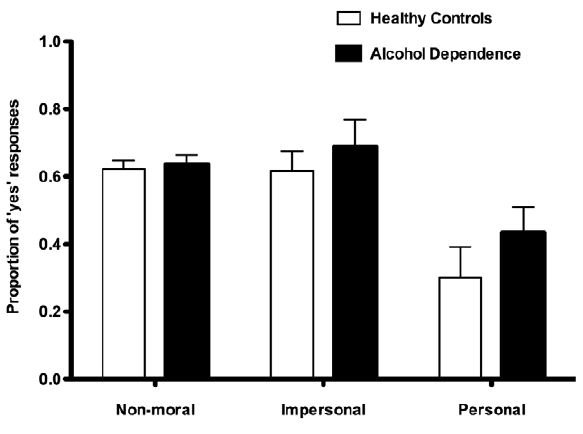
Figure 1. Moral judgments of three classes of dilemmas: non- moral, impersonal moral and personal moral dilemmas. The proportion of ‘yes’ responses are shown for the two groups. Alcohol dependent patients were more likely than healthy controls to respond ‘yes’, i.e. endorsing the proposed utilitarian action, when faced with moral personal dilemmas (P=0.024). However, no such difference was found for non-moral (P=0.377) or impersonal moral dilemmas (P=0.161). Error bars indicate 95% confidence intervals.